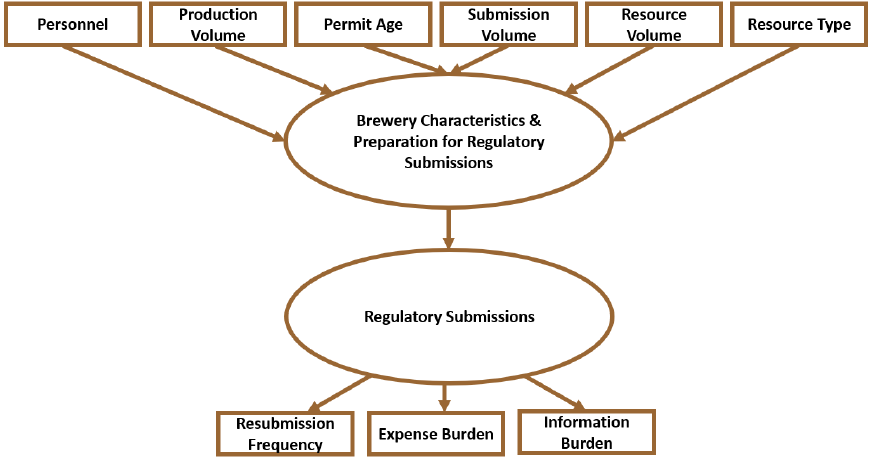
Figure 1. Prediction of Regulatory Submission Outcomes Using Brewery Characteristic Indicators.